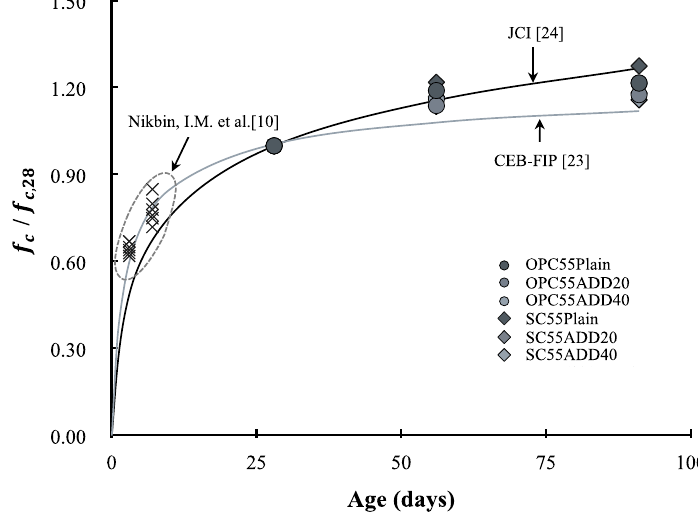
Figure 15. Variation of compressive strength as a function of age.